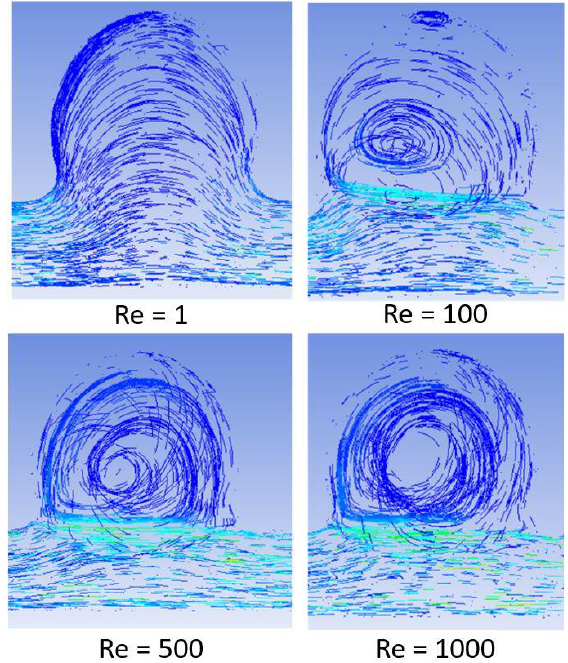
Figure 6. Streamlines for different Re.